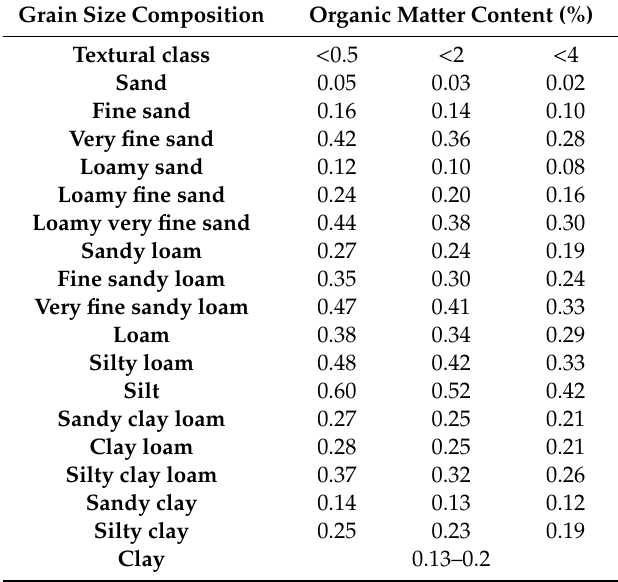
Table 2. Soil erodibility factor K